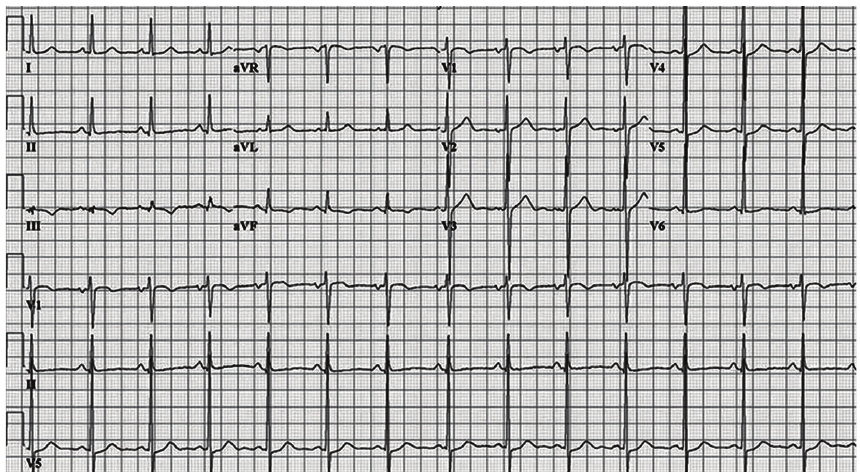
Figure 5: Follow-up 12-lead ECG exhibited normal sinus